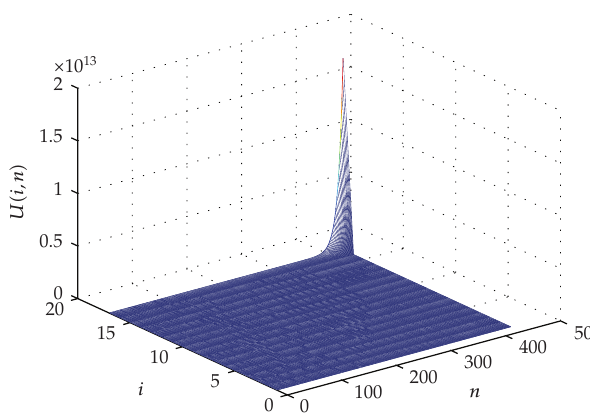
Figure 2: Evolution of the discrete solution, q (cid:2) 2, p (cid:2) 2 (cid:3) implicit scheme (cid:4) .